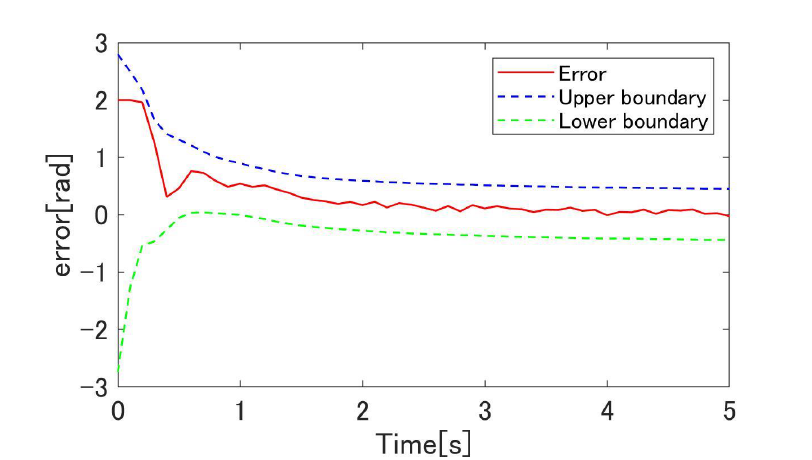
Figure 23. Enlarged view of Figure